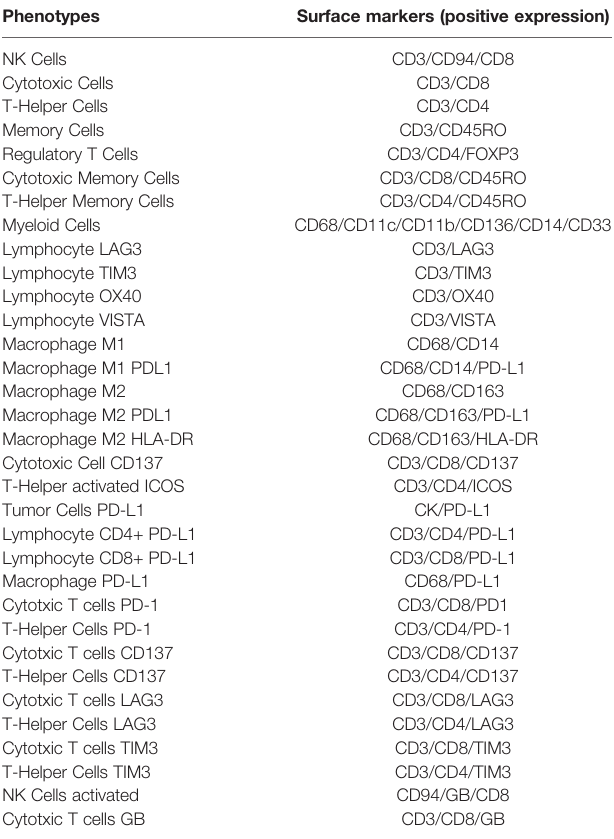
surface marker expression used in translational research. Phenotypes